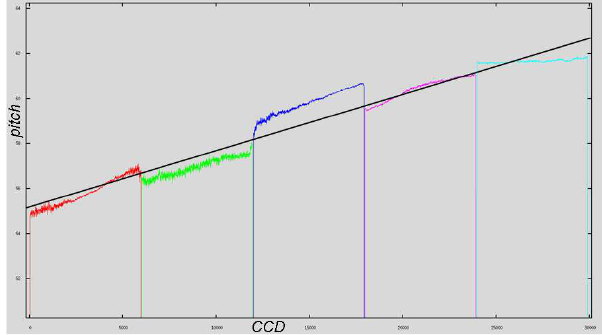
Figure 8: yaw estimation using cross acquisitions Once the linear part of the model has been withdrawn, the residuals seen in Figure 9 show the viewing directions in the two directions (row wise and column wise). The Figure 10 shows the viewing directions for a Pleiades CCD array assessed with the cross acquisition (red line with a noise less than 0.05 m rad max) and the supersite (blue line with a noise less than 0.15 m rad max). The inter-array overlapping is also measured in order to minimize geometric default between two successive detectors.